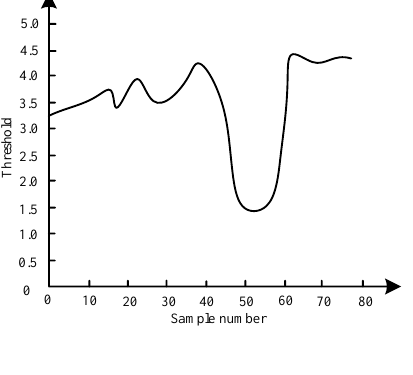
Figure 6. DTW calculation results